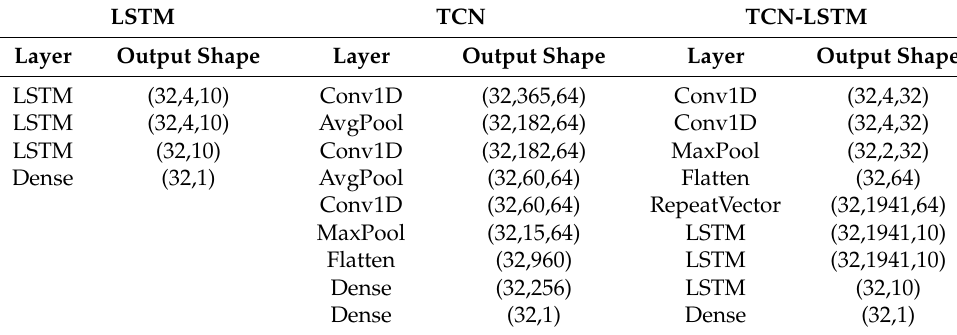
Table 2. The architectures of the used basic prediction